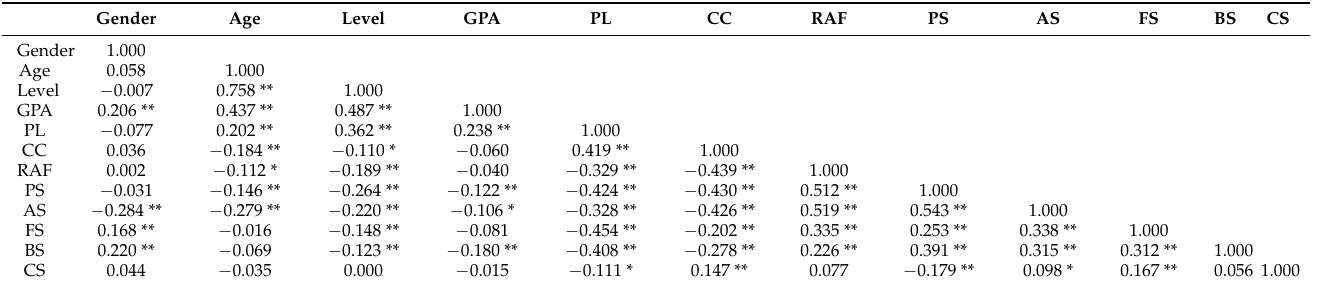
Table 6. Correlation